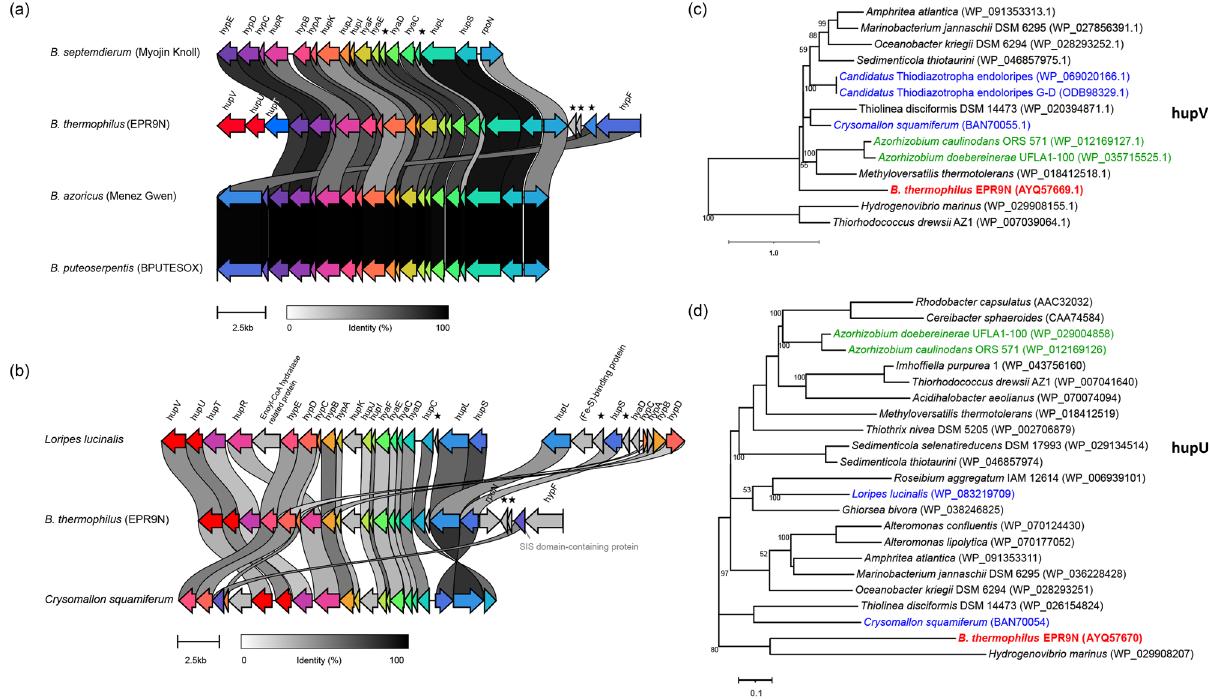
Figure 4. Schematic visualization of hydrogenase cluster regions in ( a ) Bathymodiolus mussel thiotrophic symbiont genomes, ( b ) symbiont genomes of Loripes lucinalis, B. thermophilus EPR9N, and Crysomallon squamiferum . Loripes lucinalis symbiont genome possesses two distinct hydrogen clusters. Star marks are hypothetical genes. Phylogenies of H 2 -signaling hydrogenases ( c ) HupV and ( d ) HupU genes, respectively. The phylogenetic trees were inferred by using the maximum likelihood method with bootstrap values on the tree branches (only over 50 are shown). The taxa in green are of the symbionts of legume host Sesbania , in blue are the symbionts of marine gastropods, and in bold red are the symbiont of B. thermophilus EPR9N. GenBank accession numbers of proteins are presented in